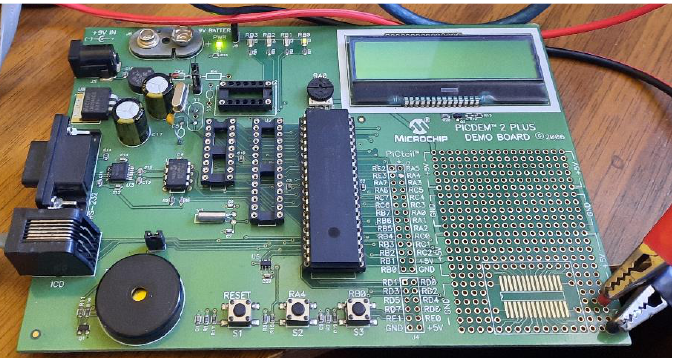
Figure 7. PICDEM development platform used for PIC18F performance testing.